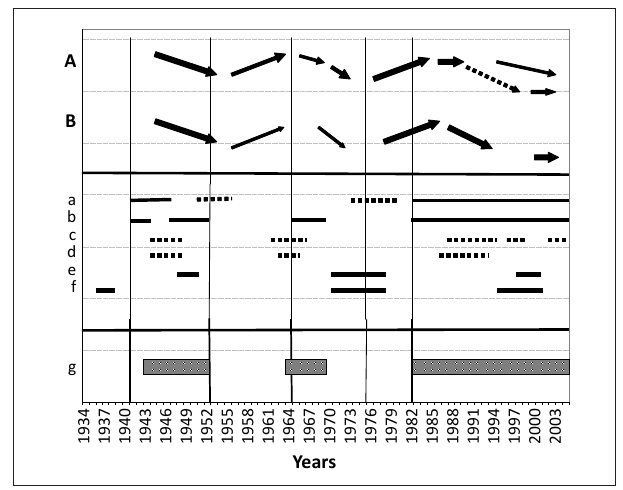
FIGURE 6: Long-term population trends reconstructed from historical records and extant census data for (A) blue wildebeest and zebra in southern Kruger National Park (bold arrows) and trend deviation for northern populations (broken line arrow), and (B) selectively feeding antelope species: sable, roan, tsessebe and eland (bold arrows; thinner arrows for sable and eland